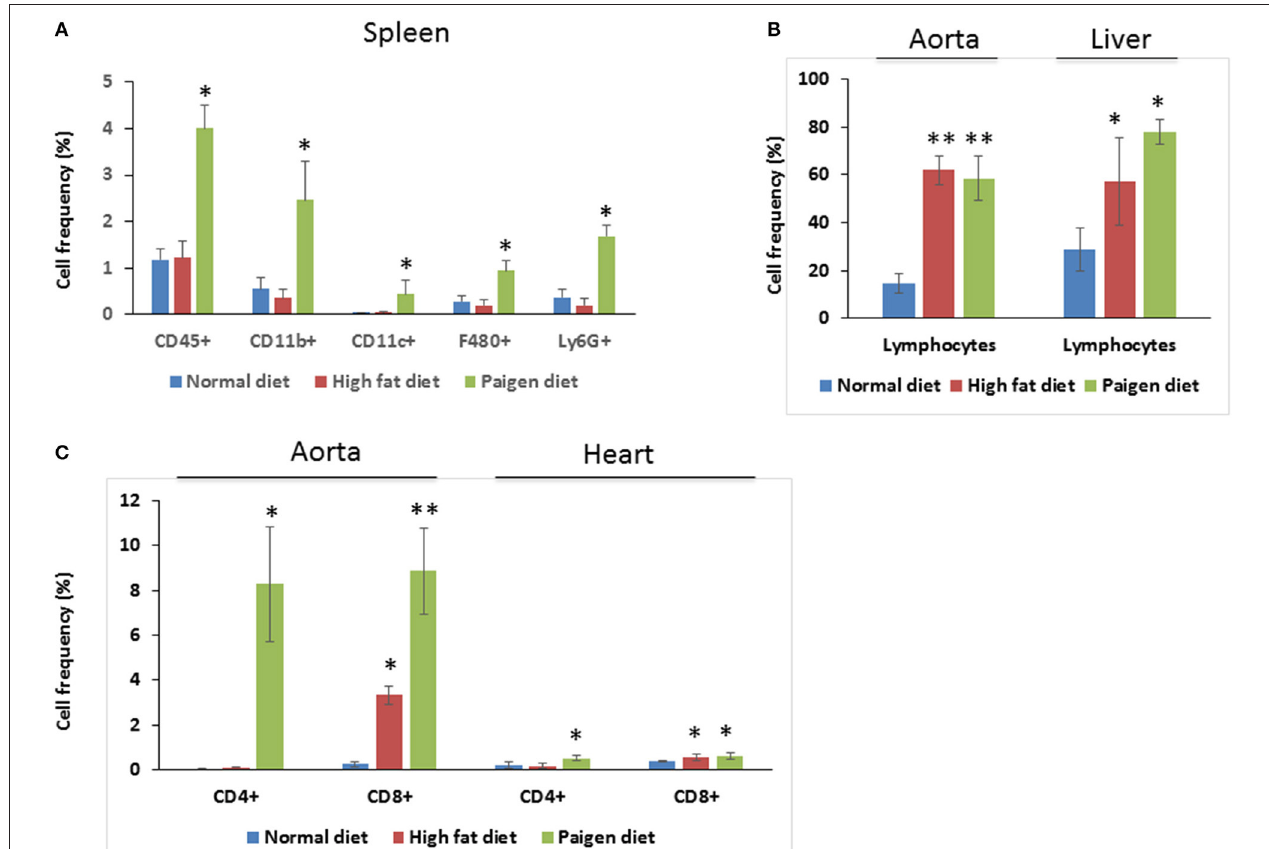
FIGURE 4 | Immune cells profiling in the tissues of Normal diet (ND)-, High fat diet (HD)-, and Paigen diet (PD)-fed mice. Single cell suspensions were prepared from solid tissues (aorta, heart, and liver) and processed for FACS analyses. Combination of surface markers for T-lymphocytes was CD45, CD4, and CD8 and myeloid cells were stained for CD45, CD11b, CD11c, F4/80, and Ly6G. (A) Frequency of total myeloid cells and cells positive gated for CD45, CD11b, CD11c, F4/80, and Ly6G in the spleen. (B) Frequency of lymphocytes in the aorta and in the liver, of gated cells. (C) Frequency of cells gated for CD4 and CD8 in the aorta and in the heart. N = 3.4. * p < 0.05; ** p <